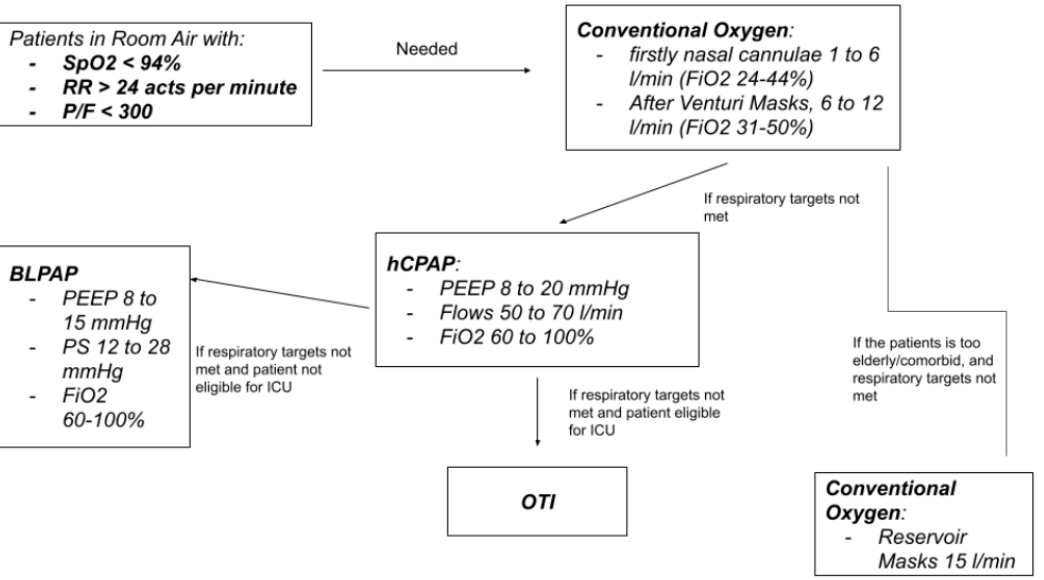
Figure 1. Stepwise approach to oxygen and ventilatory support for patients with COVID-19-related respiratory failure.